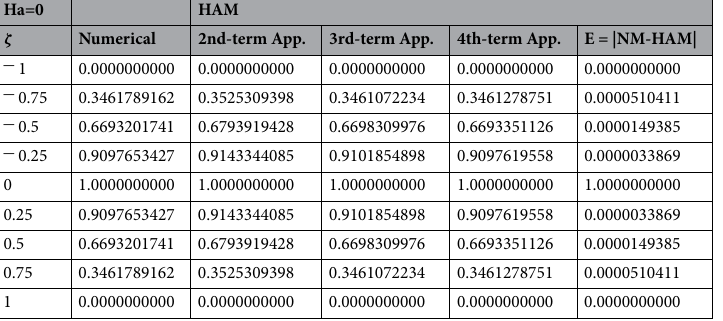
Table 4. Comparsion between of numerical 31 and applied method of velocity distribution for diverging channel υ(α , δ , ζ) , when Re = 50, Ha = 0, ω = 3 0 , α = 0, δ = 1, h = − 1 for Cu-H 2 O nanofluid.